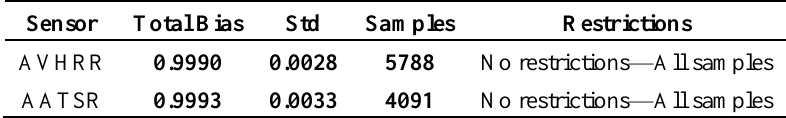
Table 7. Summary of results for all SNO match-up targets for the AVHRR-heritage channel at 12 µm based on inter-comparisons with MODIS on AQUA. The total bias is expressed as the relative bias ( i.e. , brightness temperature